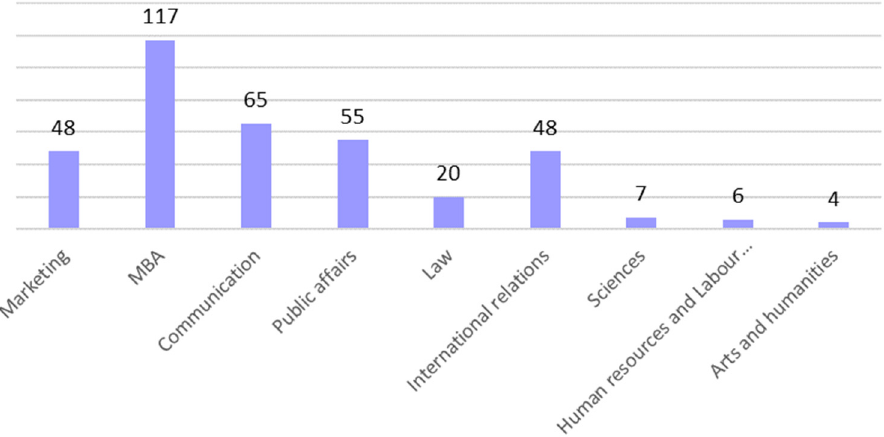
Figure 2. Distribution of postgraduate degrees held by lobbyists. Source: own elaboration.